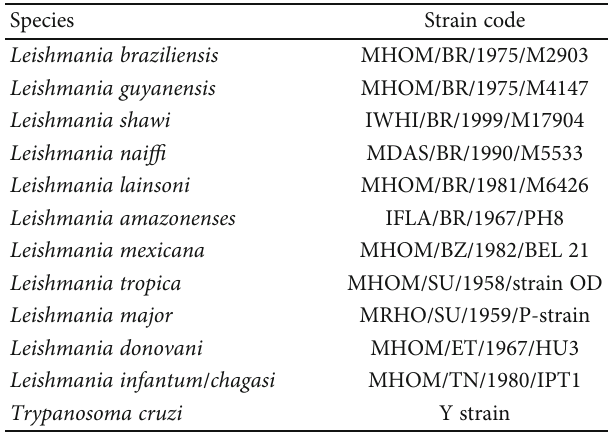
Figure 1: Forming subunits of the Leishmania spp. ribosomal RNA. Repeating unit of an RNA locus, showing the 18S (orange), 5.8S (green), and 28S (blue) regions. In the intergenic space (IGS) between the repetition units, there is an element of repetition called IGSRE. It is estimated that the IGS region size is between 2 and 3 kb. Table 1: Codes of di ff erent reference strains used in conventional and real-time PCR